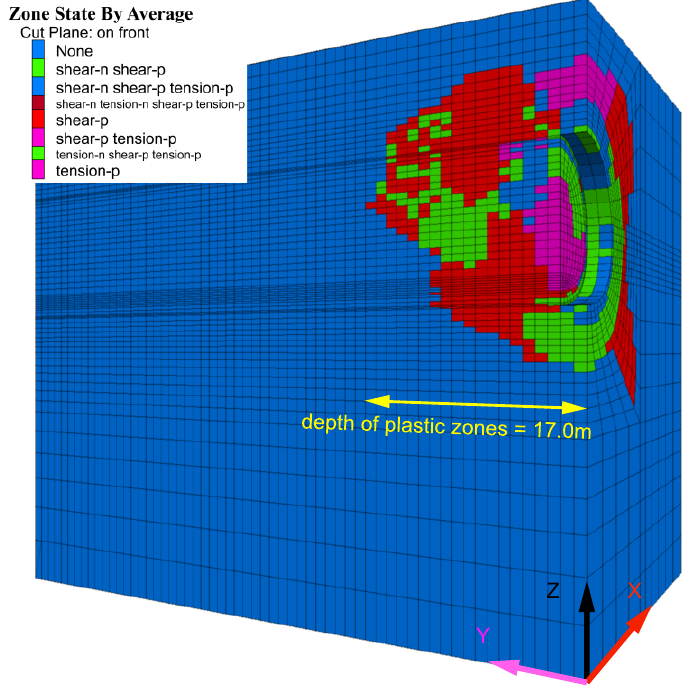
Figure 14. Distribution of plastic zones without support.